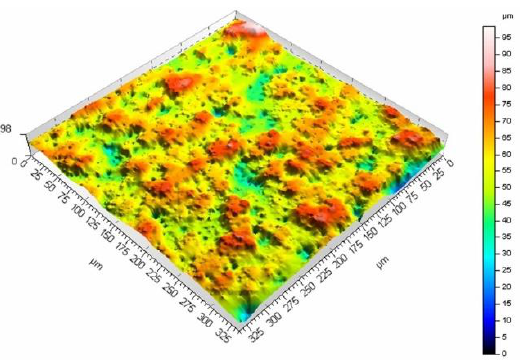
Figure 11. Surface morphology produced from a pulse duration of 120 ns and velocity of 200 mm/s.